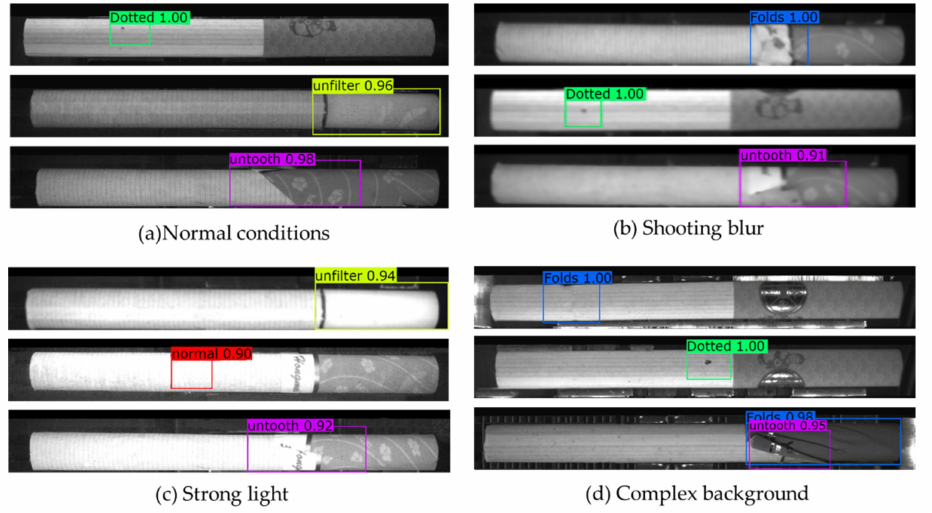
Figure 14. Example of experimental